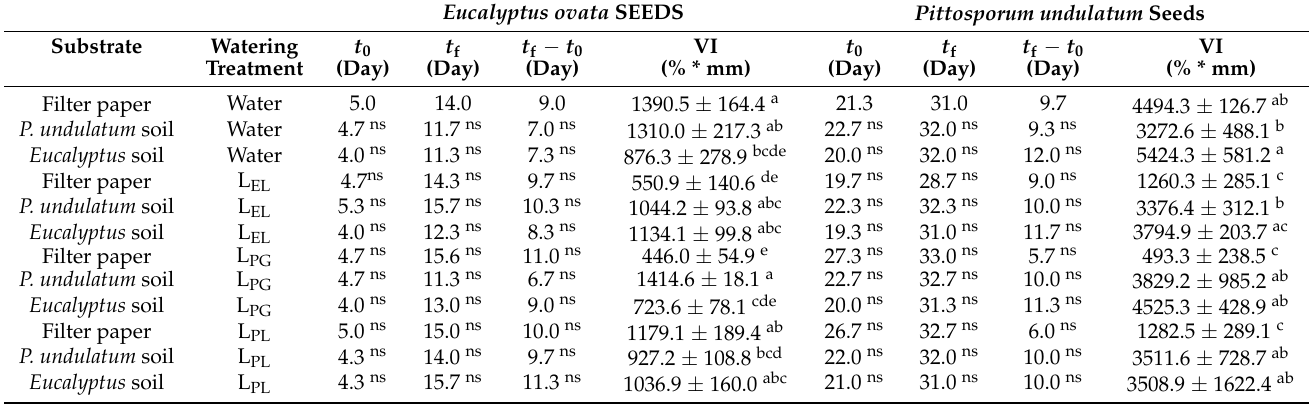
Table 3. Germination of Eucalyptus ovata and Pittosporum undulatum seedlings under different substrates (i.e., Filter paper; P. undulatum soil; Eucalyptus soil) and different watering